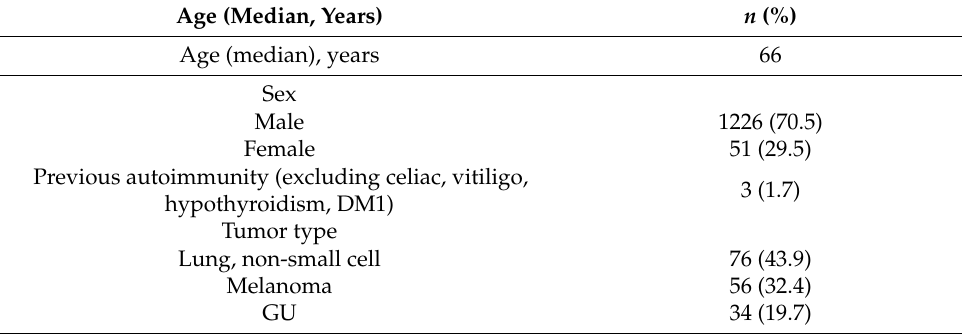
Table 1. Patient